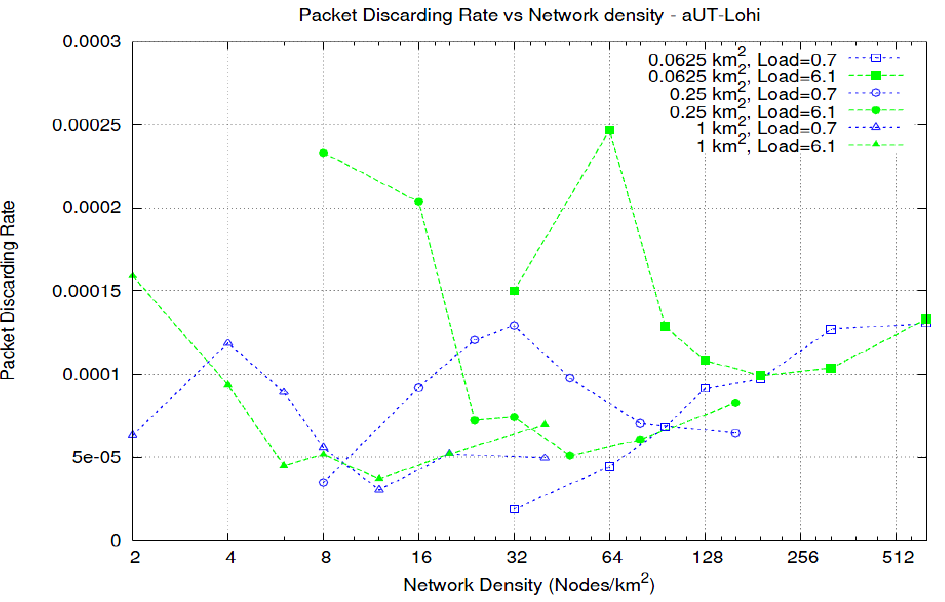
Figure 5. Packet Discarding Rate versus Node Density, for different network sizes and different offered